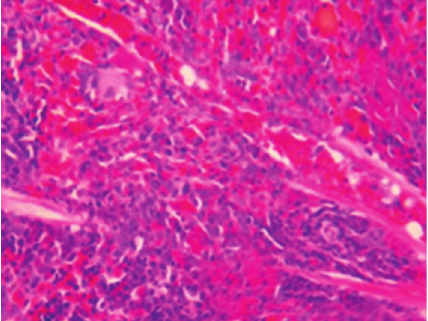
Figure 10: Sham-operated group 28 days; enlargement of splenic sinusoid and hyperplasia of fibrous tissue; HE ×